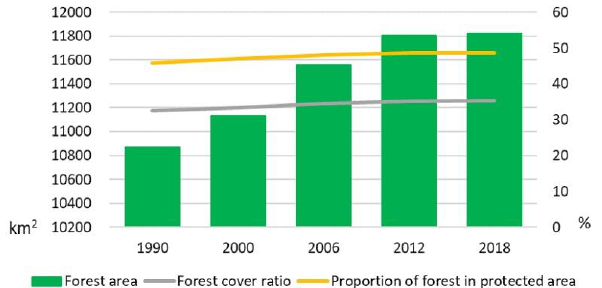
Figure 15. Forest area in km 2 and forest cover in protected Figure 15 . Forest area in km 2 and forest cover in protected areas.